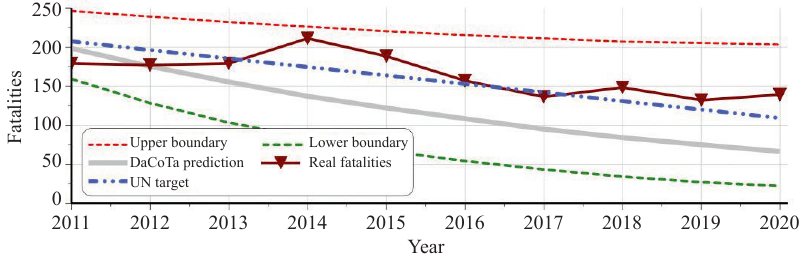
Figure 15. DaCoTA forecast, UN target and real data of road traffic